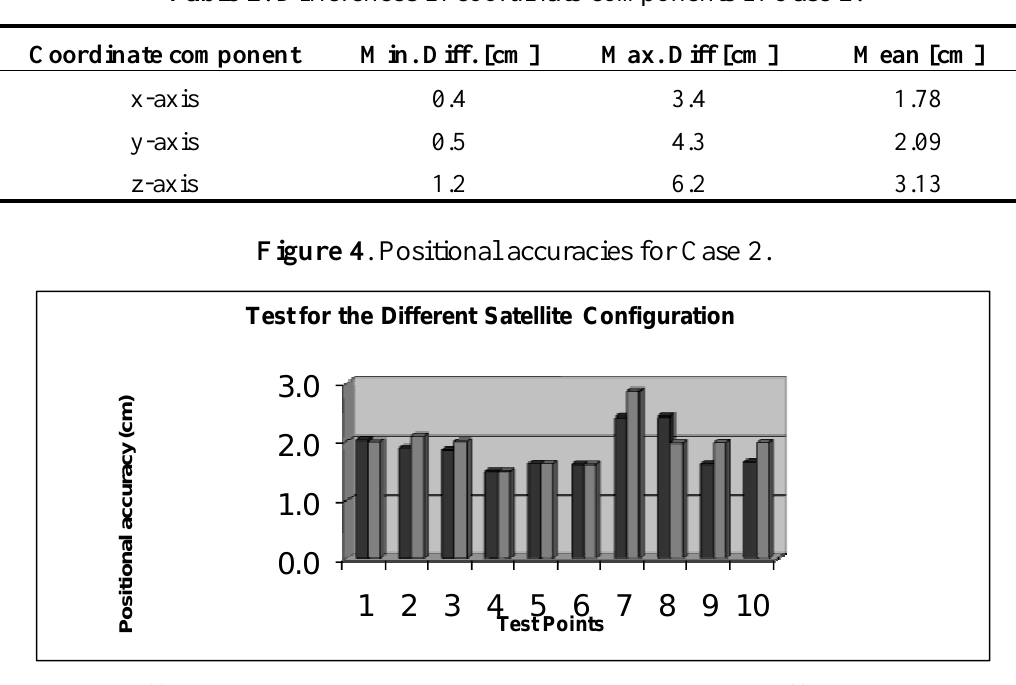
Table 2 . Differences in coordinate components in Case 2.